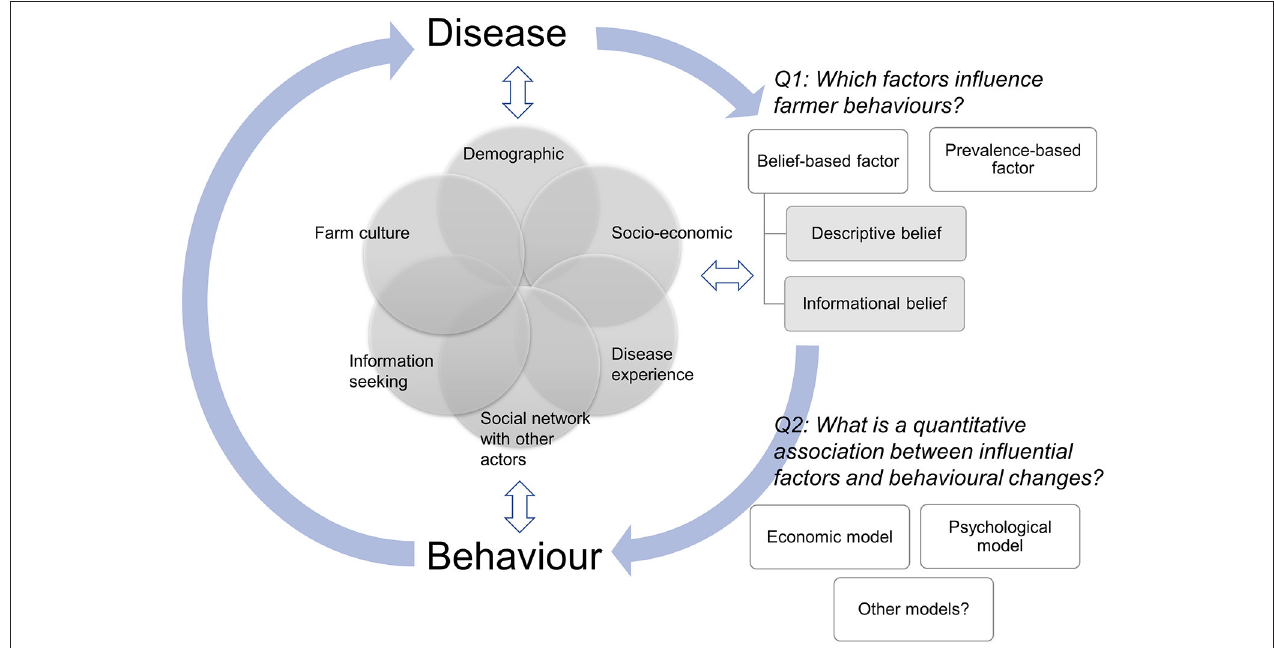
FIGURE 1 | Schematic diagram of the feedback loop between disease and behavior. Disease influences farmer behaviors through prevalence-based and belief-based factors, which are influenced by various farms’ and farmers’ characteristics (e.g., demographic factors, socio-economic status, and social network with other actors). Behavior in turn changes disease dynamics. Farms’ and farmers’ characteristics influence both disease and behavior, which also influence farms’ and farmers’ characteristics. We highlighted two key areas (Q1 and Q2) that need further studies in order to accurately capture the inter-relationships between disease and dynamic human